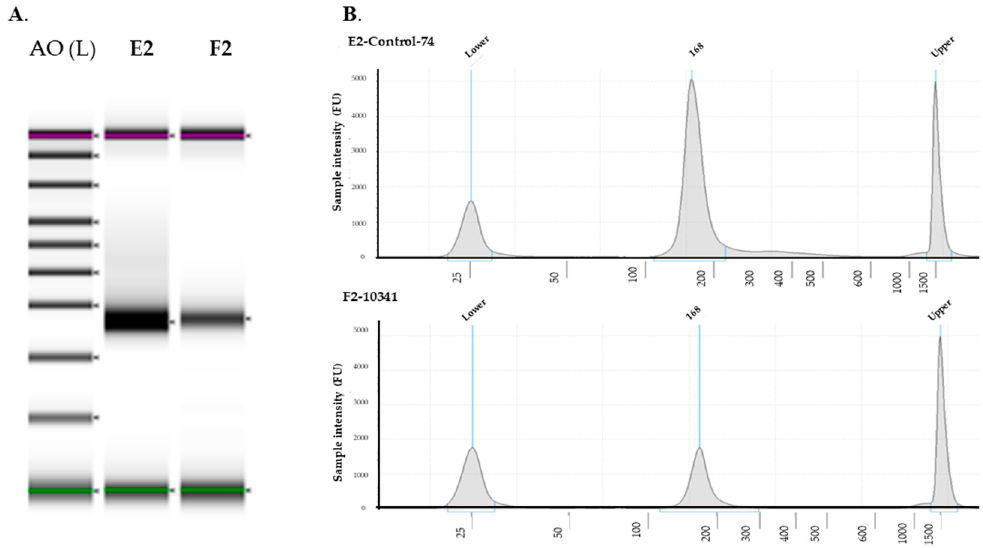
Figure 1. miRNA quality analysis. miRNA was isolated from FFPE tissues from European Americans and Filipino Americans. ( A ) Quality was checked by gel image, ( B ) miRNA QC was performed by RNA screentape. A0, ladder; E2, European cancer tissue; F2, Filipino cancer tissue. QC, quality control.